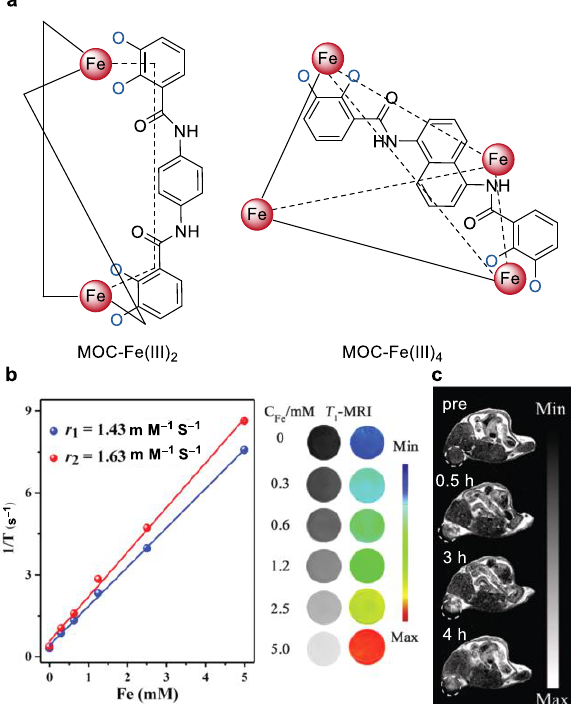
Figure 11. ( a ) Chemical structures of the metal – organic cages with two (MOC – Fe(III) 2 ) and four Fe(III) centers (MOC – Fe(III) 4 ), ( b ) relaxivities of MOC – Fe(III) 4 in solution and the corresponding MRI images, and ( c ) in vivo magnetic resonance images of BALB/c mice with 4T1 tumors before and after intratumor injection of MOC – Fe(III) 4. [68]. Reprinted/adapted with permission from Ref. [68]. Copyright 2019, Royal Society of Chemistry.